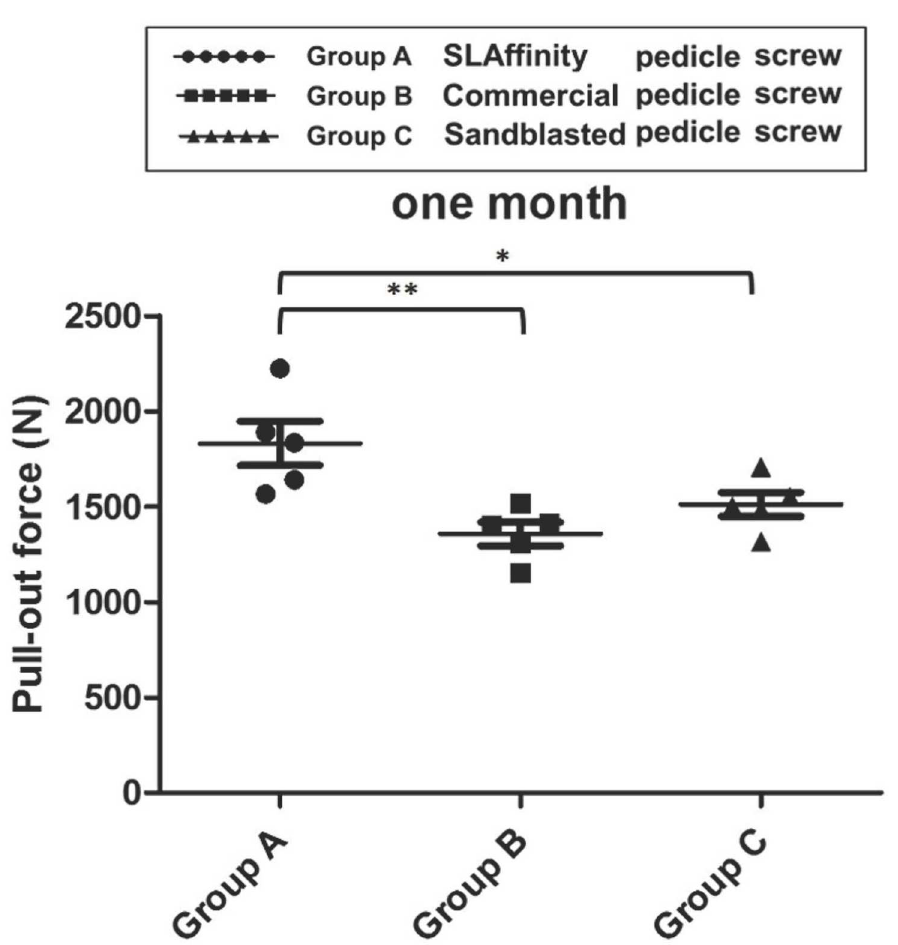
Fig 10. Comparison of pull-out force among different groups 1 month after implantation. * : p < 0.05 and ** : p < 0.01.